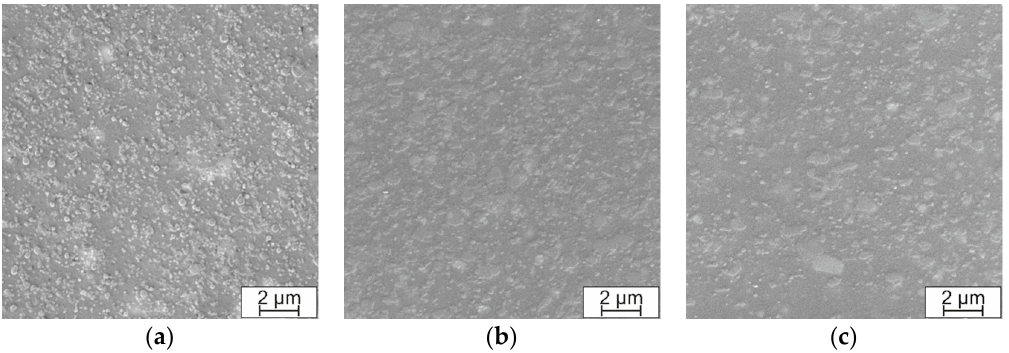
Figure 3. SEM images of AMCs produced by means of high-energy ball milling, hot isostatic pressing and extrusion in the T4 condition; matrix alloy AA2017; reinforced with SiC particles: ( a ) 15 vol % β -phase with size < 0.2 µm; ( b ) 15 vol % α -phase with size < 1 µm; and ( c ) 10 vol % α -phase with size < 1 µm. Table 1. Selected properties of powder-metallurgically produced AMCs compared to the reference matrix material without any reinforcements and a commercially available AMC (Duralcan) produced by means of a melt-metallurgical production method.